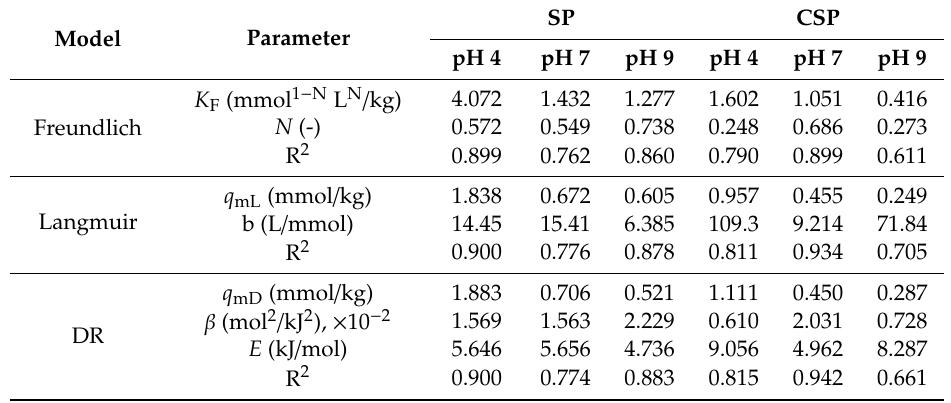
Table 4. Isotherm model parameters for Pb adsorption onto SP and CSP at pH 3, 4.5, and 7.